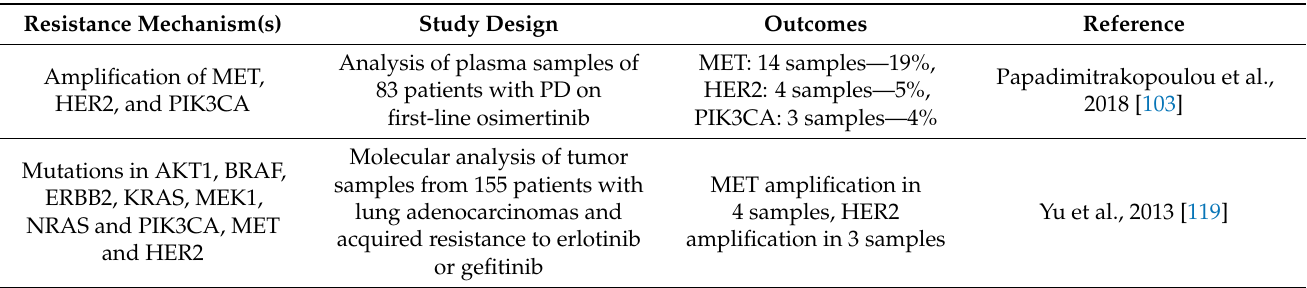
Table 1. Studies reporting EGFR independent NSCLC resistance to TKIs mechanisms. PD: Progression of Disease, NSCLC: Non-Small Cell Lung Cancer, TKIs: Tyrosine Kinase Inhibitors, ctDNA: circulating tumor DNA, NGS: Next Generation